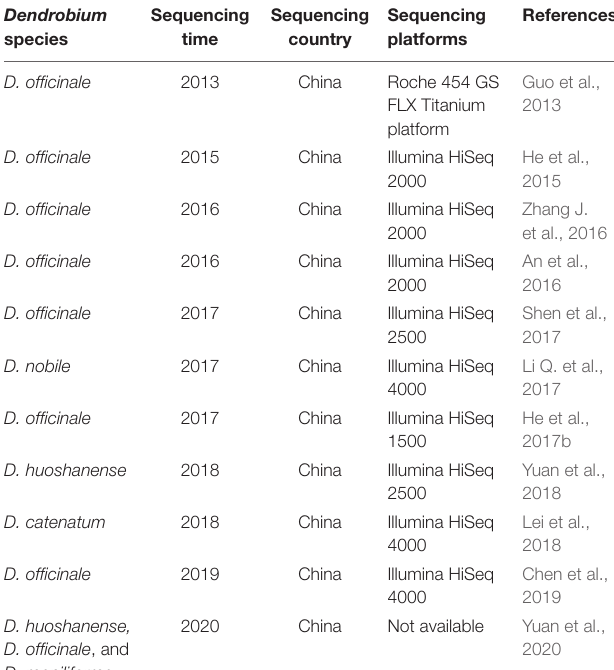
TABLE 2 | Transcriptome sequencing of medicinal Dendrobium revealing genes related to specialized metabolites